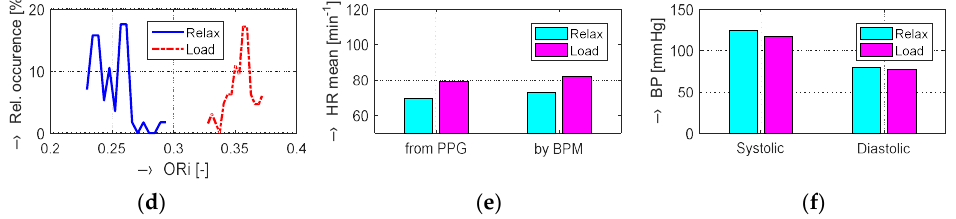
Figure 5. Visualization of changes in evaluated human cardiovascular parameters determined in Relax and Load phases with raising HR and slightly falling BP values: box-plot of basic statistical parameters of ( a ) ORi, ( b ) TD P-P , and ( c ) W 23 values; ( d ) comparison of histograms of ORi values; ( e ) bar-graphs of HR determined from the PPG signal and measured by the BPM device; ( f ) comparison of systolic and diastolic blood pressure values; male person.